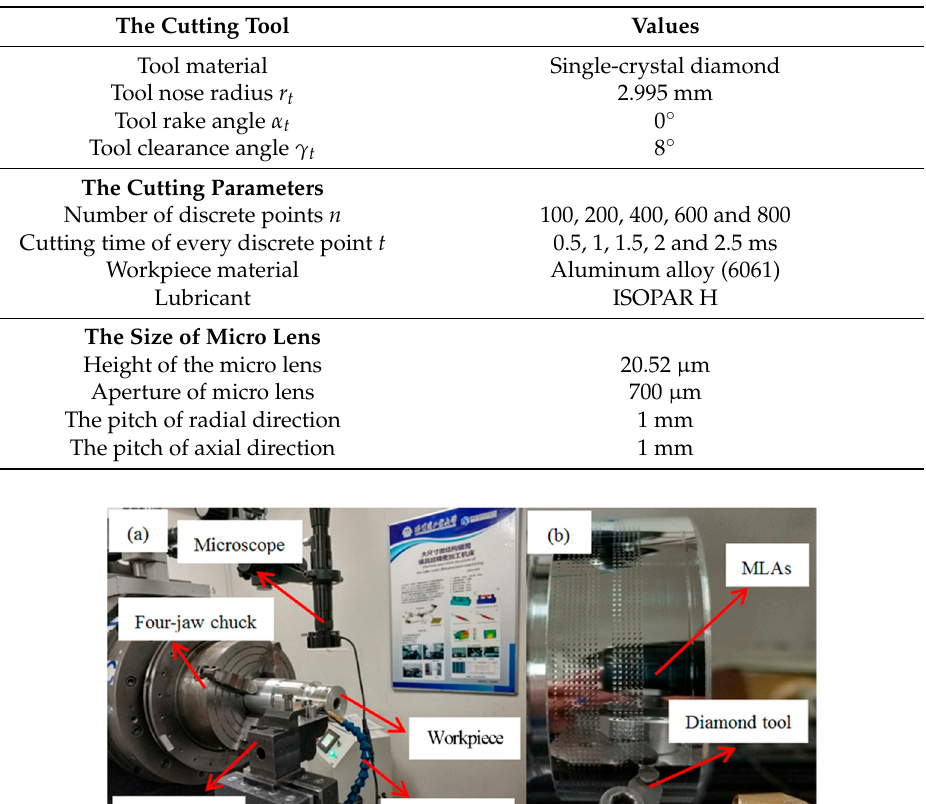
Table 2. Experimental conditions for generation of micro lens arrays (MLAs).